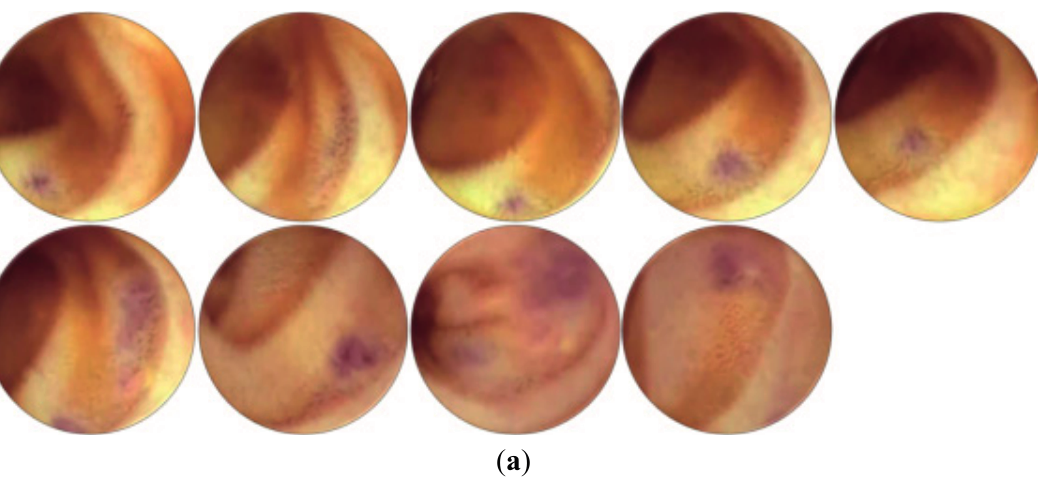
Figure 11. Comparison of manual summary with summaries generated by three different summarization techniques. ( a ) Ground truth; ( b ) Summaries generated by the Iakovidis et al. [22]; ( c ) Summaries generated by the Ejaz et al. method [21]; ( d ) Summary generated by the proposed